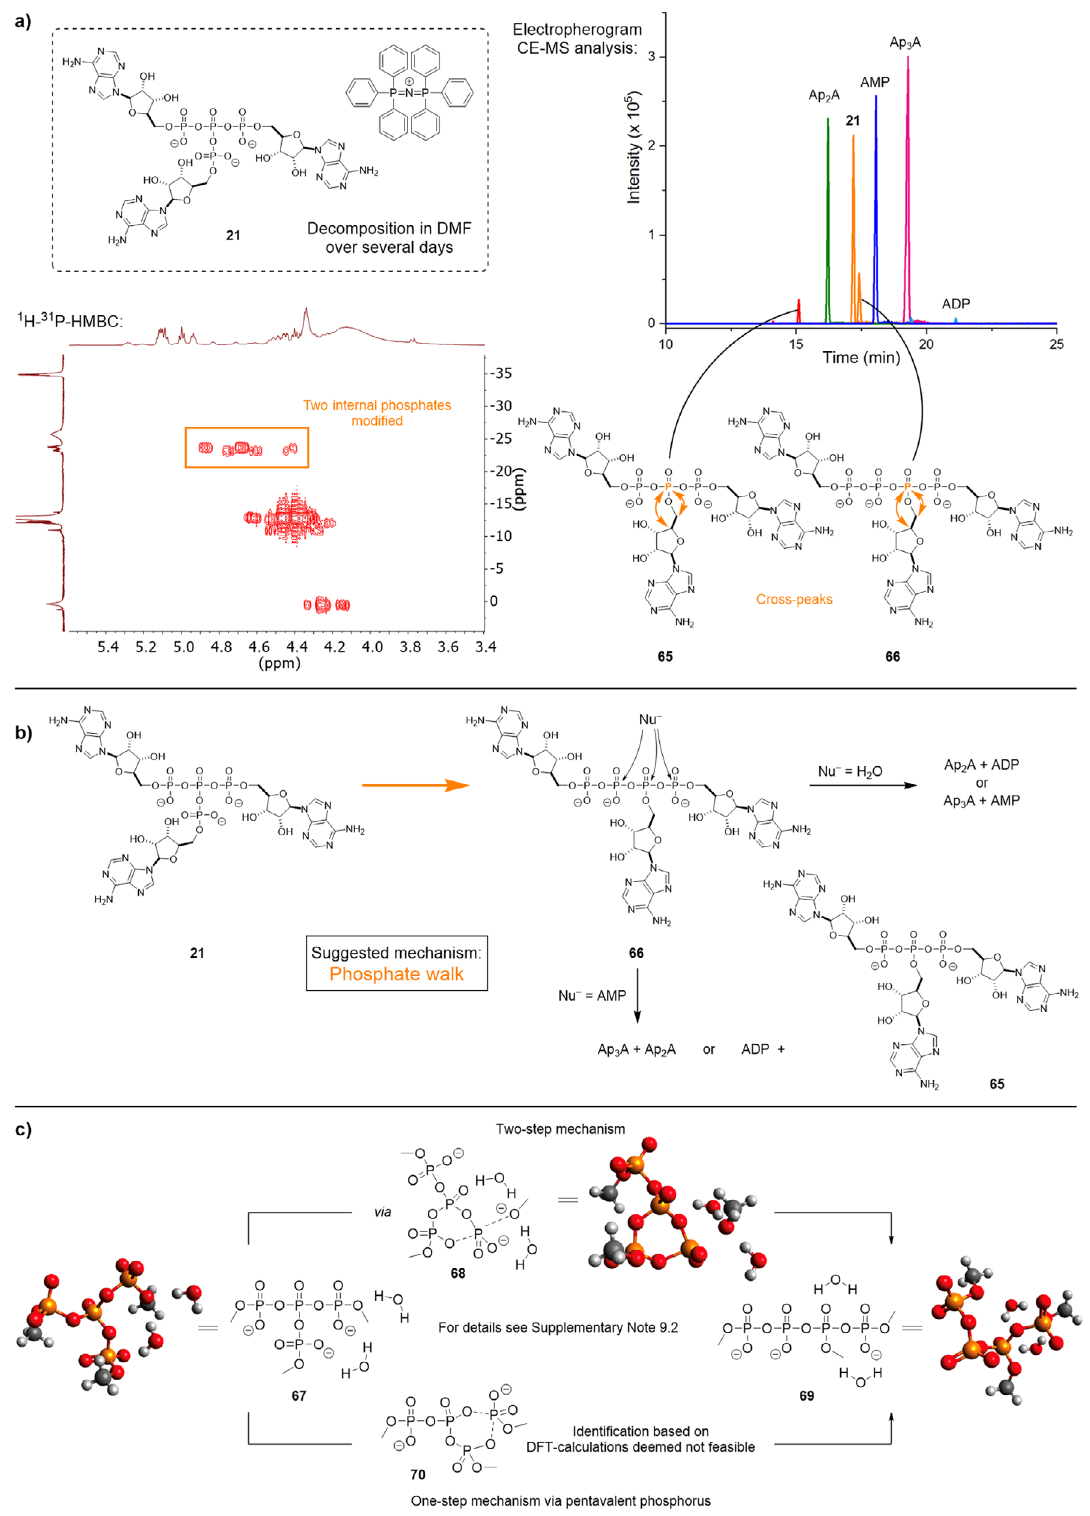
Fig. 5 Rearrangement of ultraphosphates. a Analytical results for trisadenosine ultraphosphate ( 21 ) [PPN] salt after 14 days in DMF: 1 H- 31 P-HMBC with two cross-peaks for internally modi fi ed oligophosphates. CE-MS analysis of the product mixture and proposed structures 65 and 66 for the internally modi fi ed compounds. b Phosphate walk rearrangement for trisadenosine ultraphosphate ( 21 ) and nucleophilic attack of the linearised product 66 . c Possible mechanistic pathways of the phosphate walk rearrangement for trimethyl ultraphosphate dihydrate ( 67 ). Mechanistic studies were carried out at the B97D/Def2-TZVPD(water) level of theory; for details see Supplementary Note